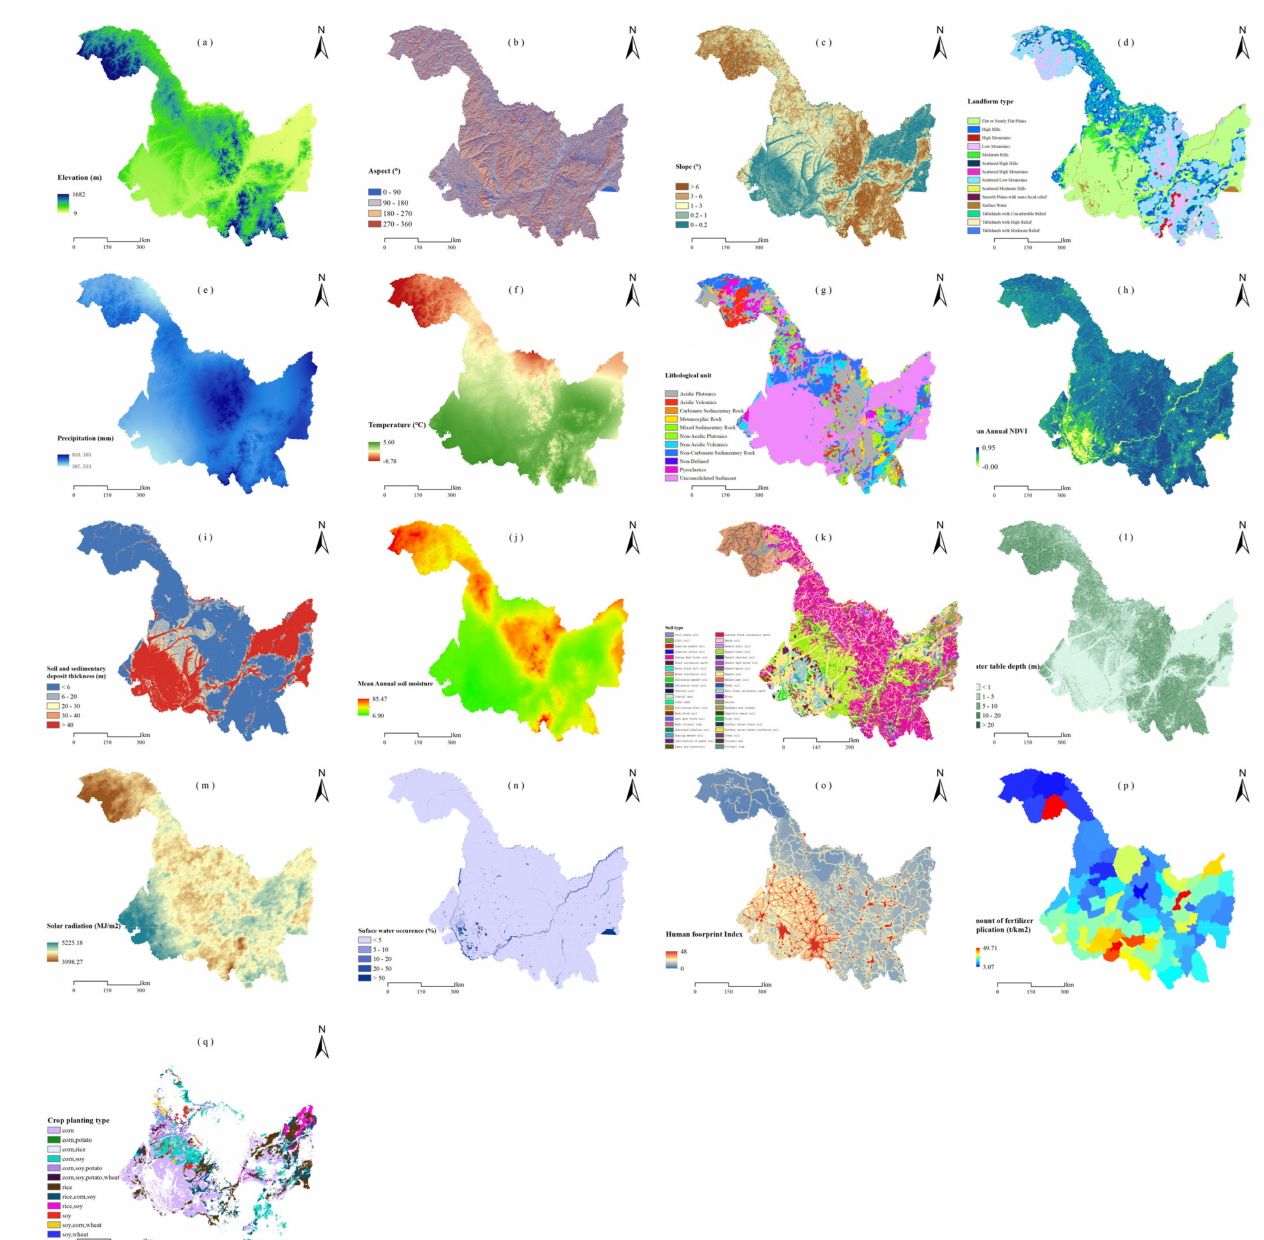
Figure 2. Distribution of covariates used in our study, including environmental covariates and human activities covariates. ( a ): Elevation; ( b ): aspect; ( c ): slope; ( d ): landform class; ( e ): mean annual precipitation; ( f ): mean annual temperature; ( g ): lithological unit; ( h ): mean annual NDVI; ( i ): soil and sedimentary deposit thickness; ( j ): soil moisture; ( k ): soil type; ( l ): water table depth; ( m ): solar radiation; ( n ): surface water occurrence; ( o ): human footprint; ( p ): the amount of fertilizer application; ( q ): agronomic management